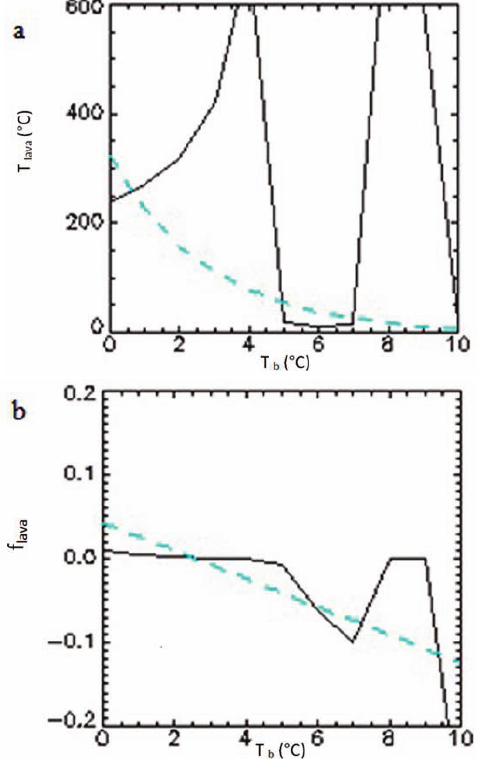
Figure 10. (a) T and (b) f trends as a functions of T lava lava radiant pixel of the AVHRR image of Mount Etna on October 30, 2006. Black solid line, solution from the dual-band fit; blue dashed line, solutions from the logarithmic linear